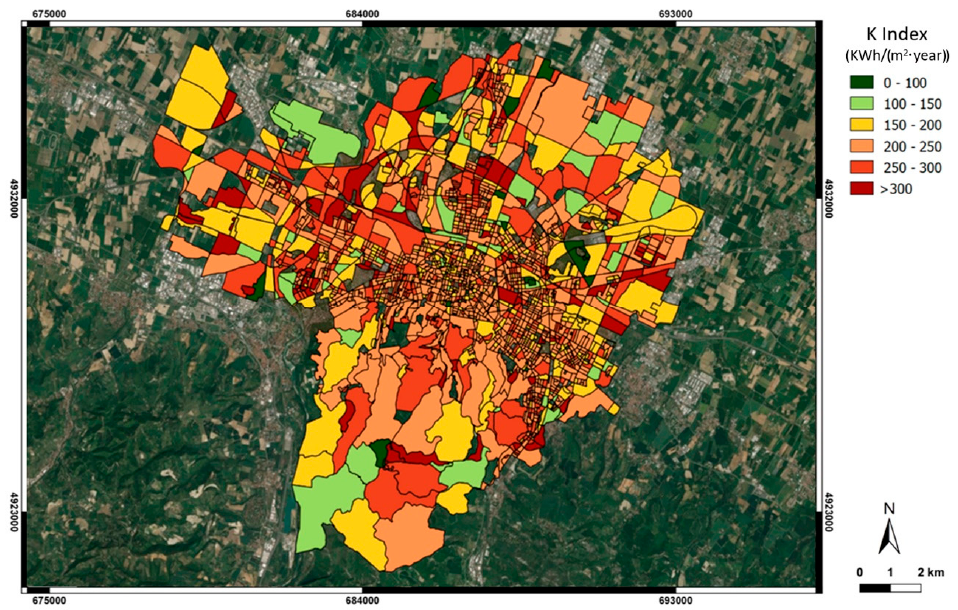
Figure 4. K index map at block scale (K BLOCK index). Bing aerial imagery is used as the base map.